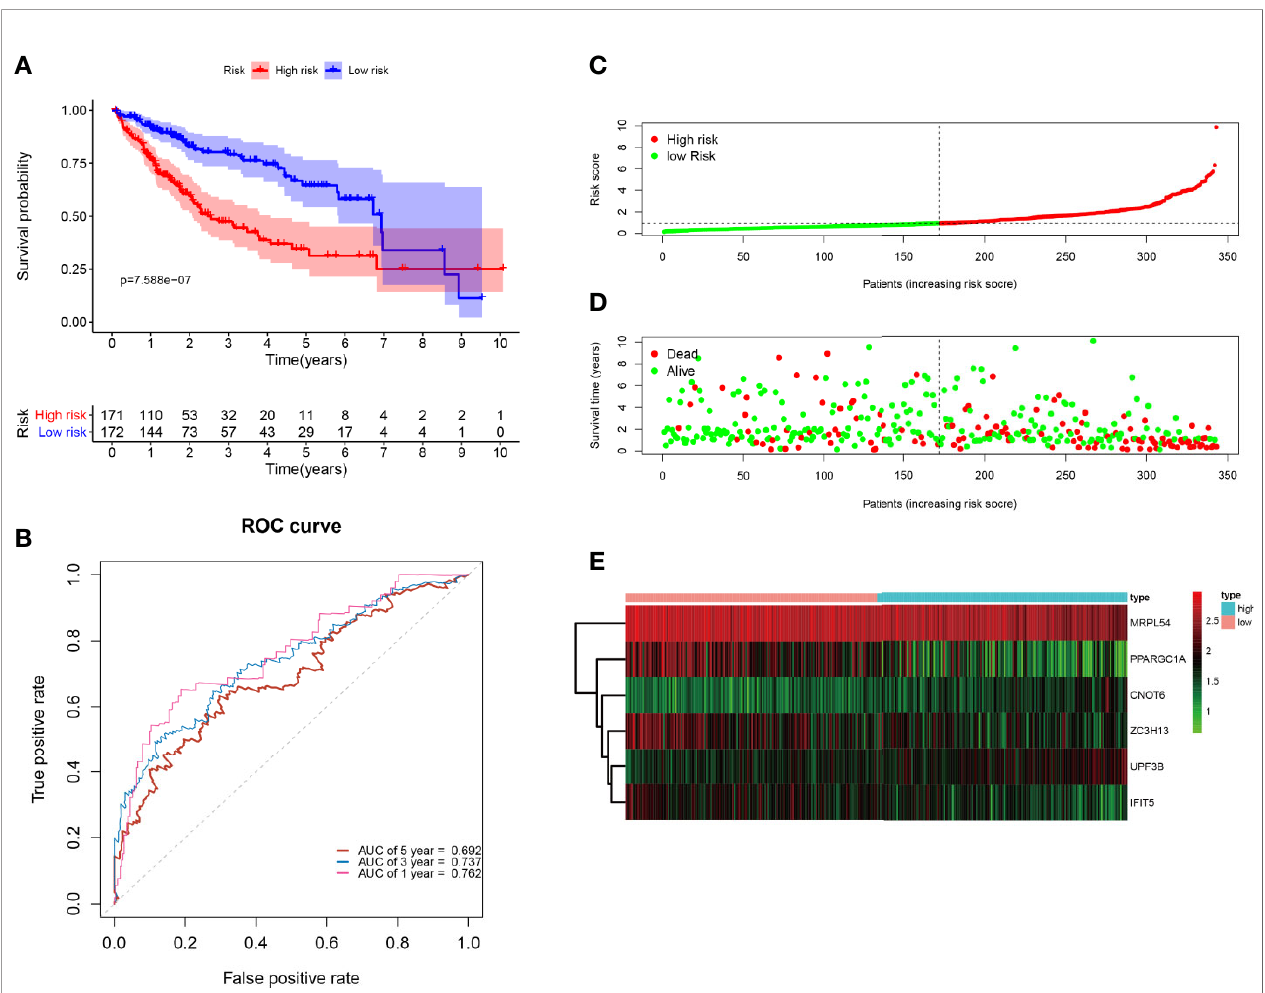
FIGURE 6 | Construction of the six-RBP gene prognostic signature in the TCGA cohort. (A) Kaplan-Meier survival curve of HCC patients in the high- and low-risk groups. (B) ROC curves for predicting 1-, 3-, 5-year overall survival. (C – E) Distribution of risk score, survival time, and heat map of six genes